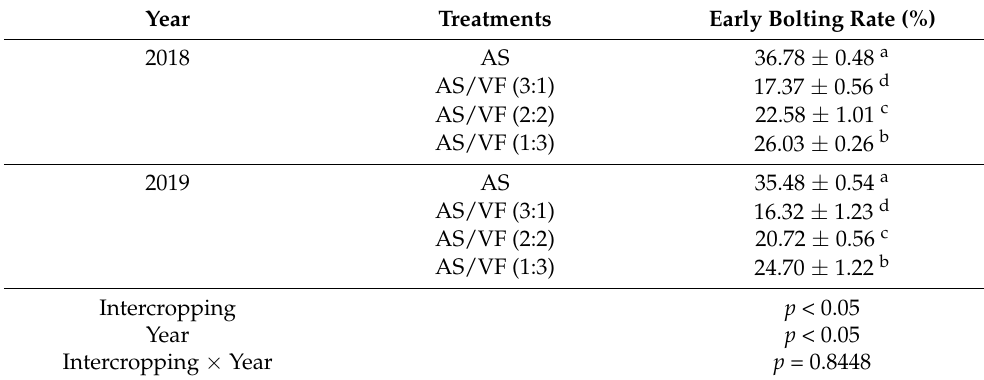
Table 2. Early bolting rate of A. sinensis under different cropping systems in 2018 and in 2019 1 .